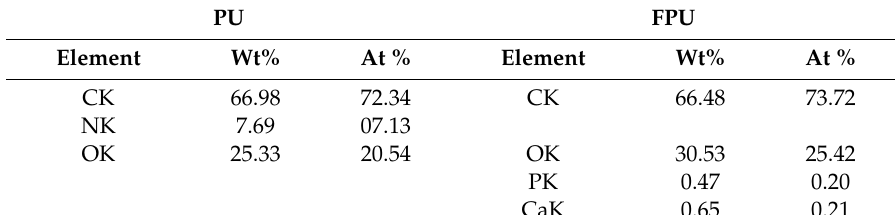
Table 4. EDX analysis of PU and FPU coating.